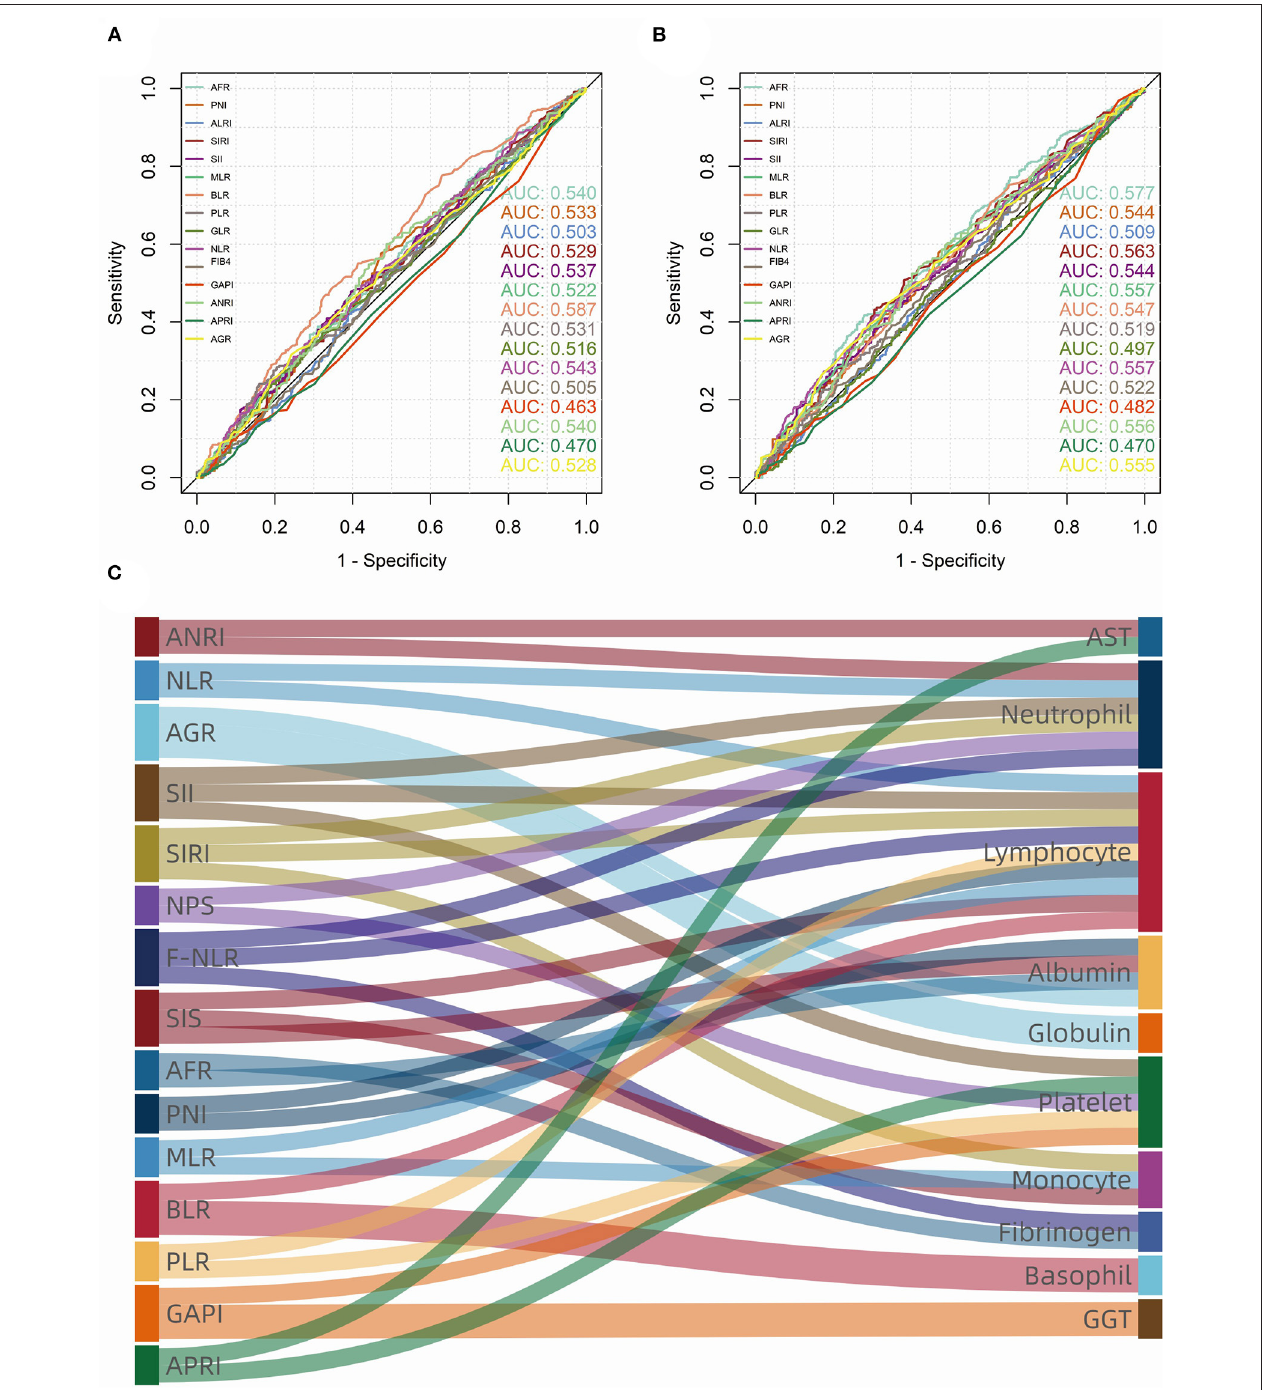
FIGURE 2 | Receiver operating characteristic (ROC) curves and area under curve (AUC) of consecutive biomarkers in training group. (A) overall survival (OS); (B) progression-free survival (PFS). (C) The sankey diagram showed fifteen biomarkers (left) that were significant ( p < 0.100) in univariate Cox analysis, which consist of ten blood cell/serum indices